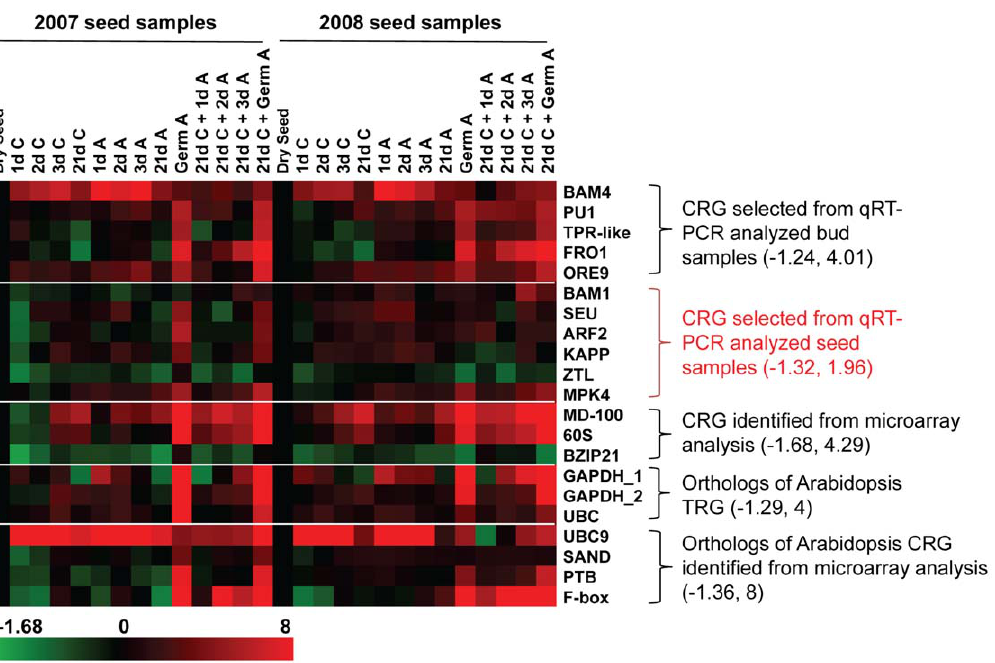
Figure 2. Candidate reference genes examined in seed samples. Two sets of germination treatment seed samples (2007 and 2008) were used to examine gene expression. The fold difference is designated as log2 value. Red indicates up-regulated genes and green indicates down-regulated genes as compared with dry seeds (black). Bars at the bottom indicate the range of transcript changes in log2 value. The range of transcript changes is also shown inside the parenthesis. CRG: Candidate Reference Genes. TRG: Traditional Reference Genes.